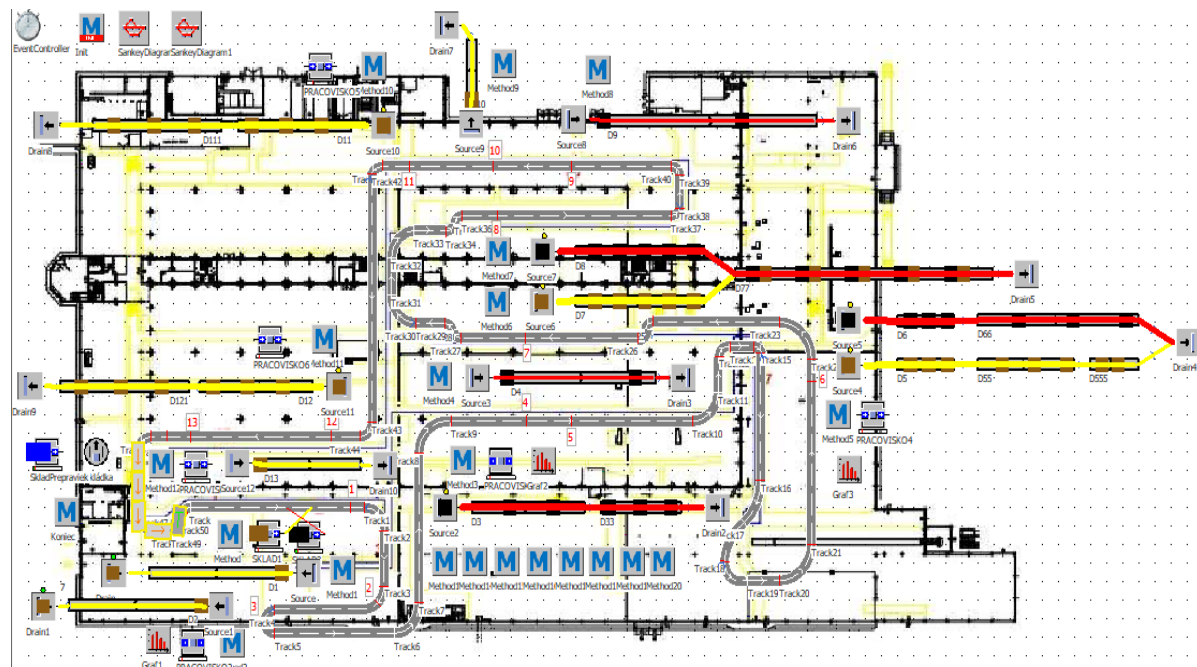
Figure 2: Layout with the definition of MilkRun route and stopping places